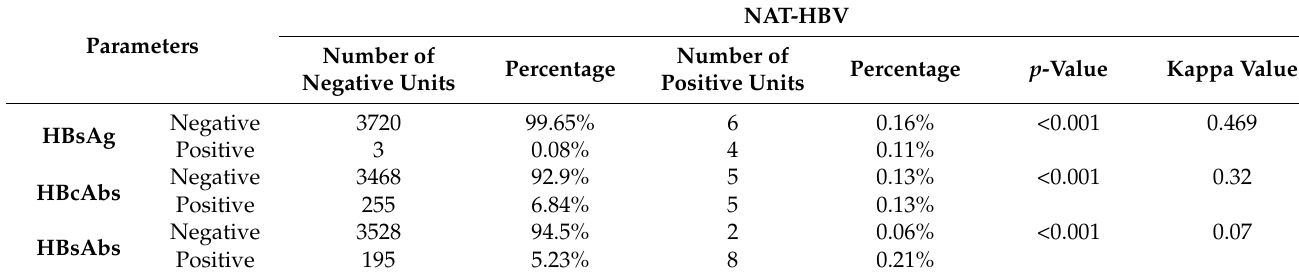
Table 6. Correlations between NAT-HBV and HBV serological markers.